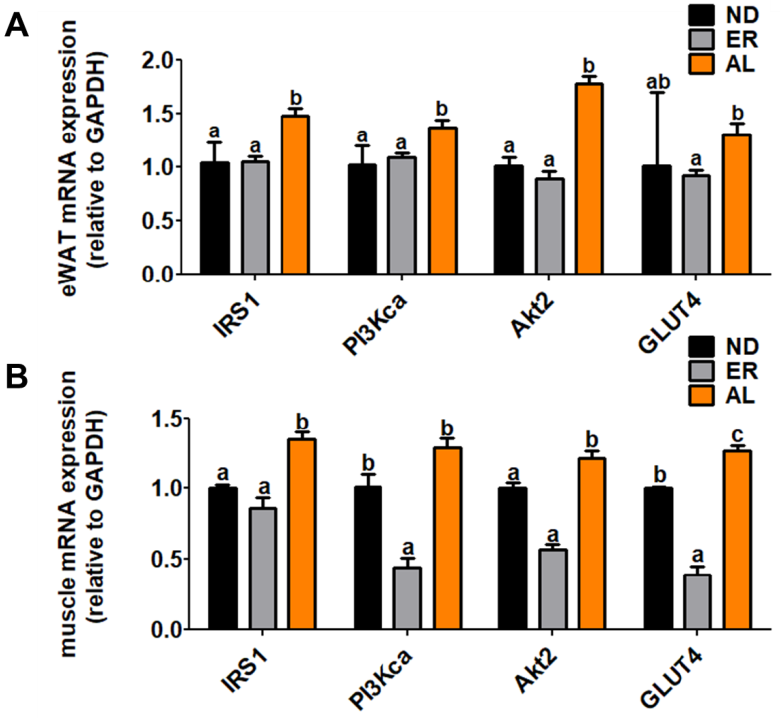
Figure 3. Effect of AL supplementation for 16 weeks on ( A ) WAT and ( B ) myocyte glucose metabolism-related gene expression in C57BL / KsJ-db / db mice. Data are mean ± S.E. a b Means values with unlike superscript letter are significantly di ff erent ( p < 0.05); IRS1, insulin receptor substrate 1; PI3Kca, phosphatidylinositol-4,5-bisphosphate 3-kinase catalytic subunit alpha; Akt2, AKT serine / threonine kinase 2; GLUT4, facilitated glucose transporter 4.